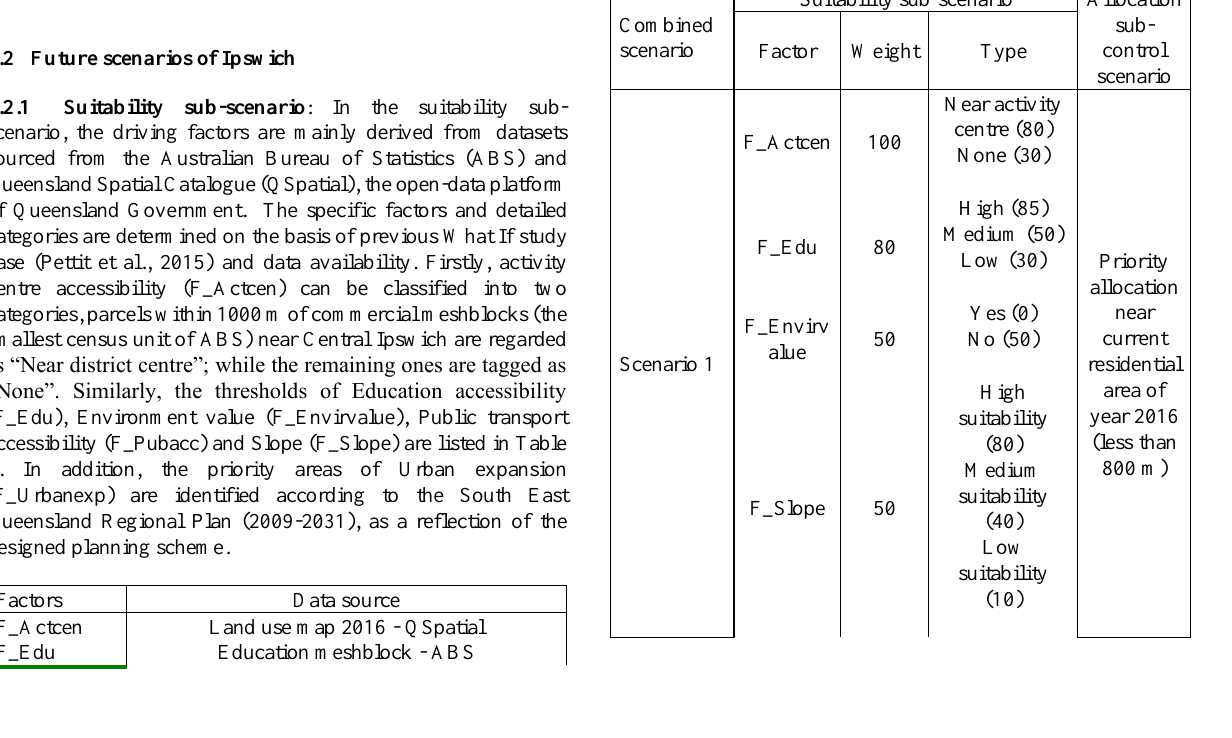
Figure 1 . Location of City of Ipswich.